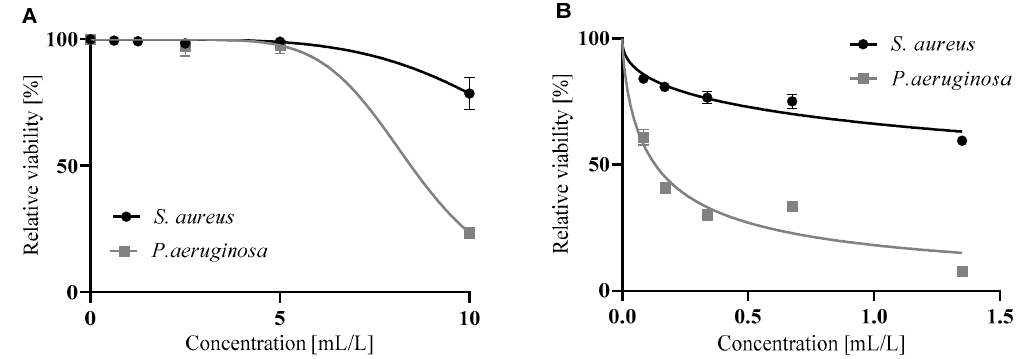
Figure 3. Disruption of maturated biofilm by lemongrass essential oil ( A ) and citral ( B ). The data are presented as an average of 16 repetitions with SEM.